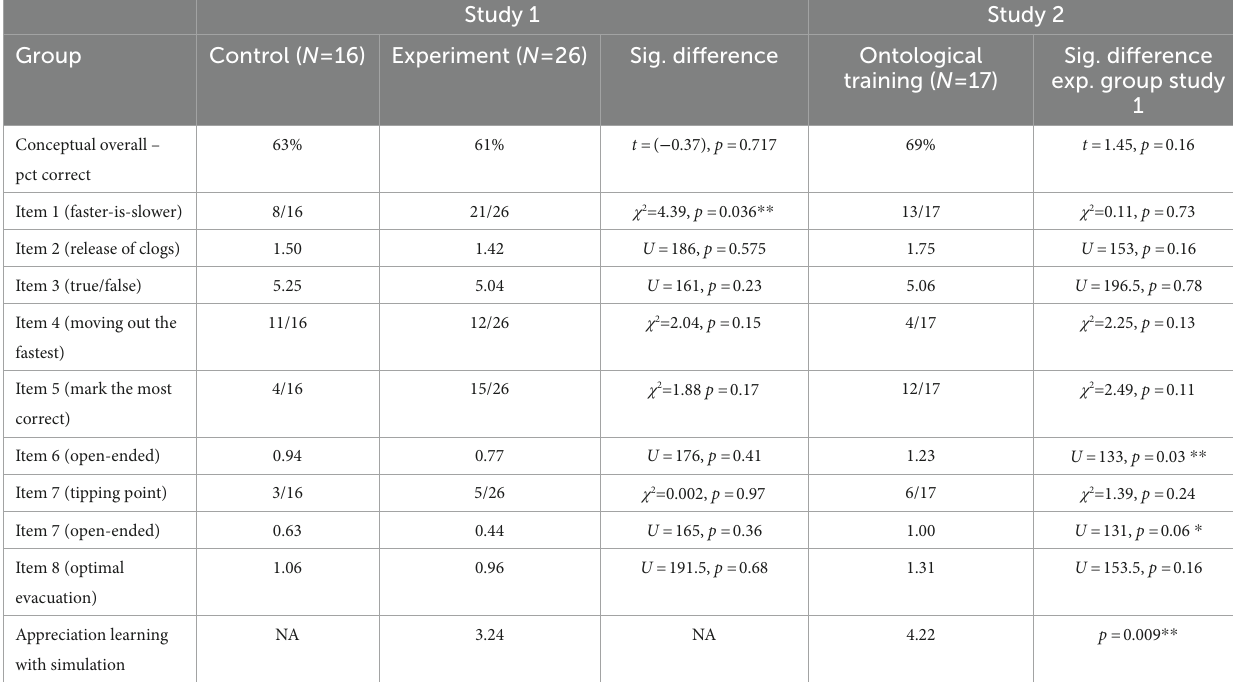
TABLE 2 Descriptive statistics of the groups in study 1 and study